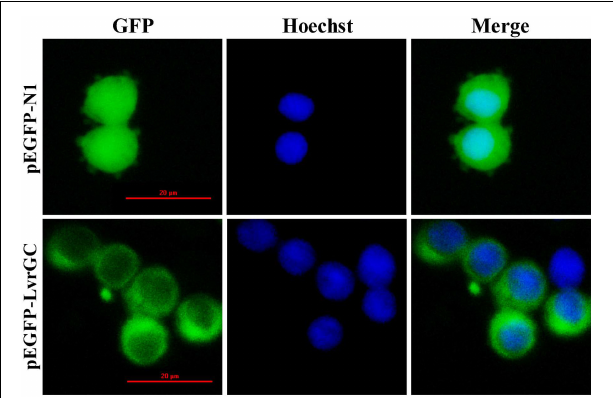
FIGURE 3 | Location of LvGC in HEK293. GFP showed the observation excited by blue light. Hoechst showed the observation excited by green light. Merge showed the merged observation excited by blue light and green